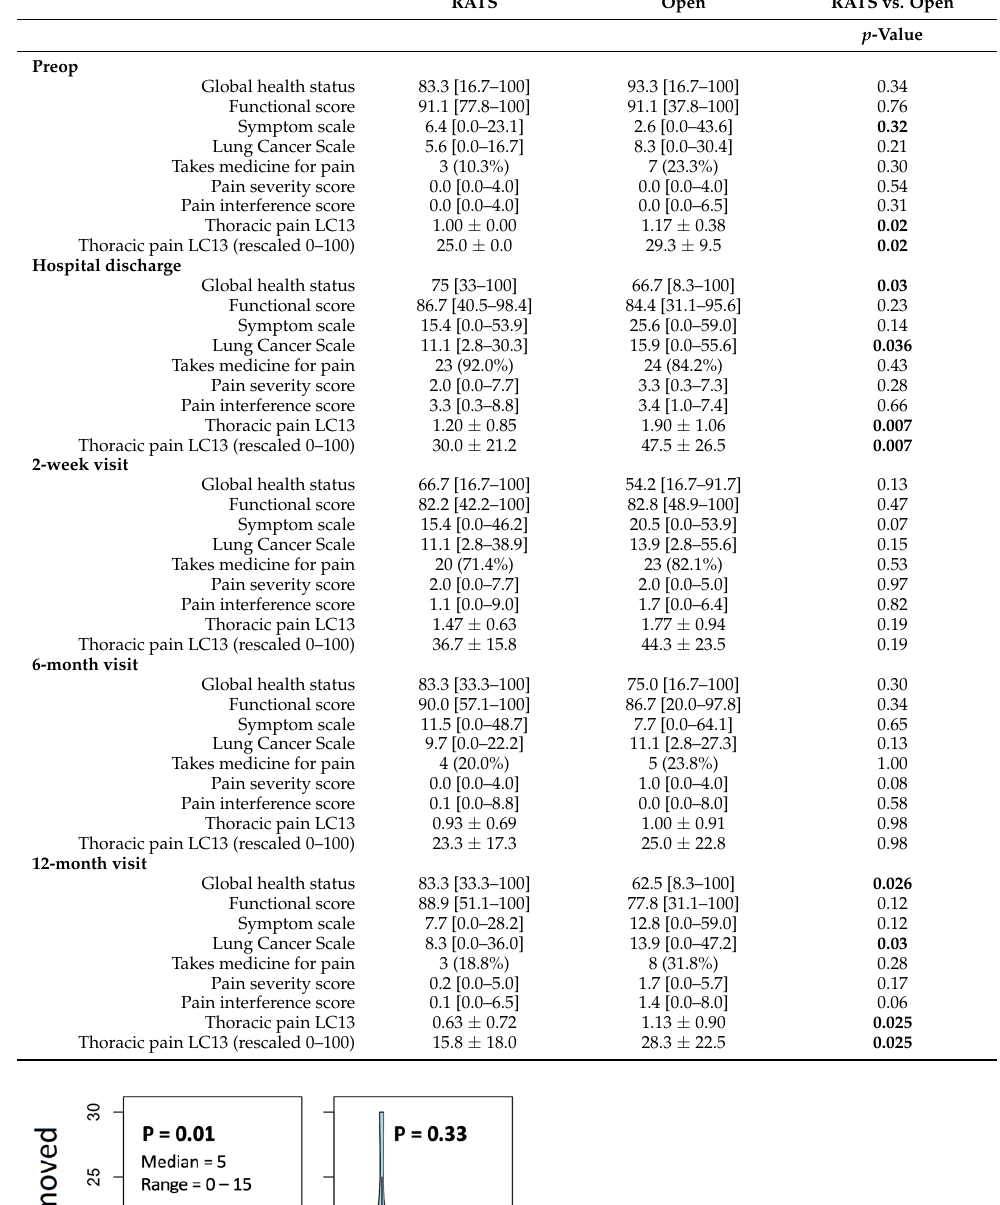
Table 3. QLQ-C30/LC13 and brief inventory pain in the matched RATS and OPEN intervention groups. RATS